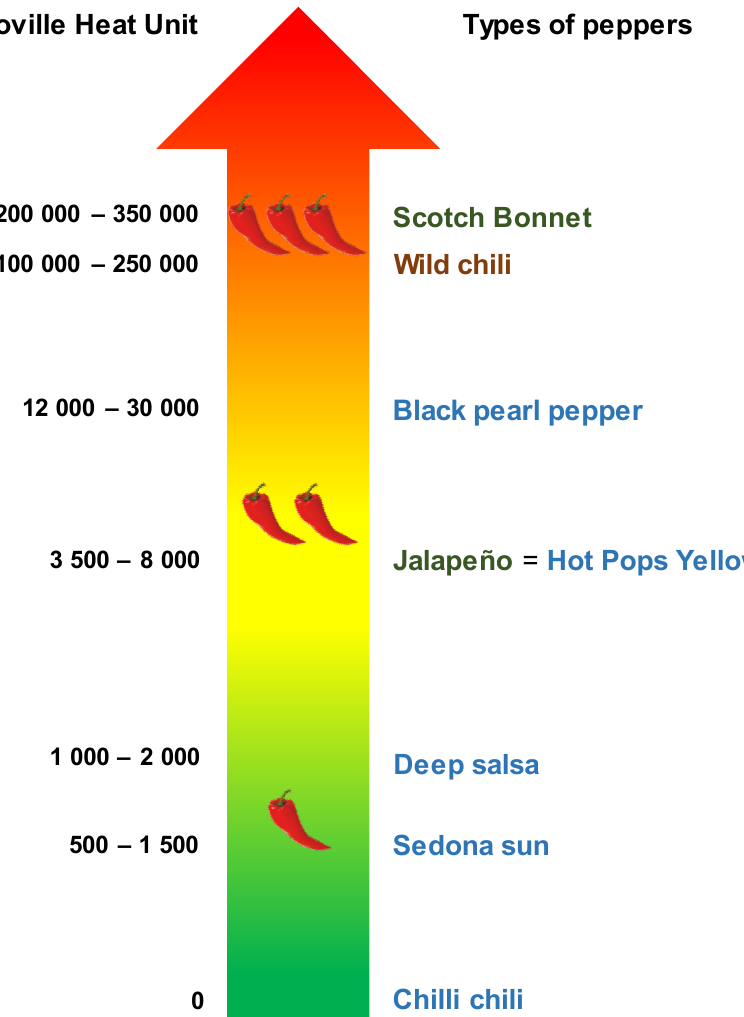
Figure 2. Characterization of capsaicin level in wild (Brown), domesticated as ornamental (Blue), and domesticated for consumption (Green) peppers according to the Scoville scale. © Y. Chabaane.